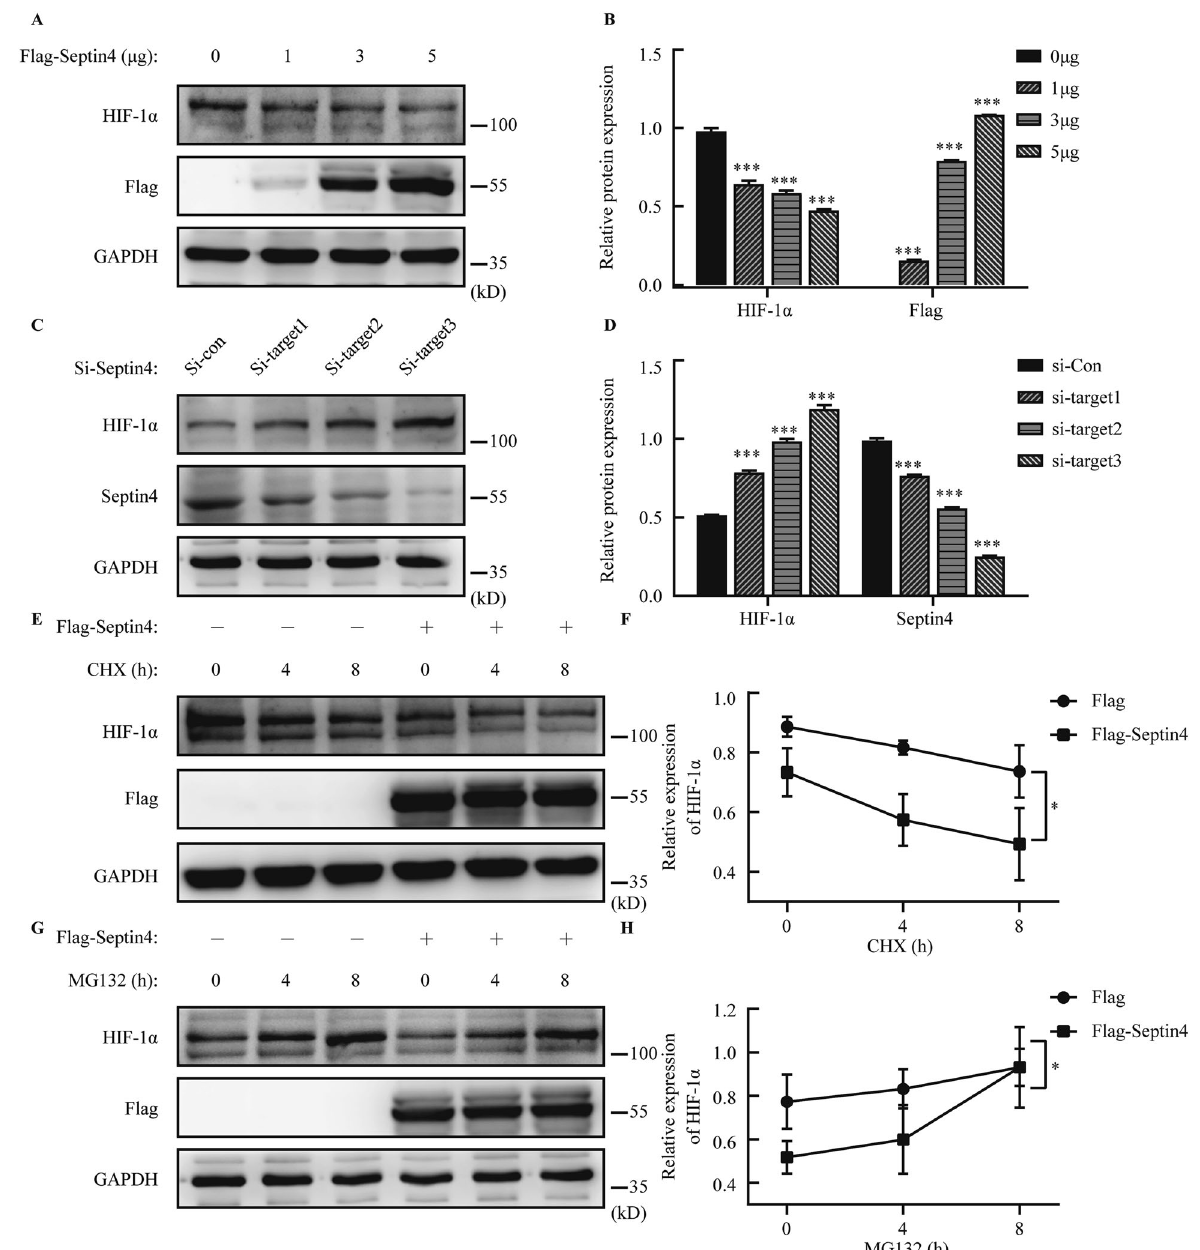
Fig. 4 Septin4 mediates the proteasome degradation of HIF-1 α . A , B Western blot analysis of the gradient overexpression of Septin4 and the changes of HIF-1 α protein expression levels. C , D Western blot analysis of the knockdown of Septin4 with three different sequences and the changes of HIF-1 α protein expression levels E , F Western blot analysis of the expression levels of HIF-1 α under the treatment of CHX for different hours in H9c2 cells transfected with vector empty or Flag-Septin4. G , H Western blot analysis of the expression levels of HIF-1 α under the treatment of MG132 for different hours in H9c2 cells transfected with vector empty or Flag-Septin4. All data are presented as mean ± SD of three repeated experiments; ***<0.001, **<0.01, *<0.05. One-way ANOVA with Tukey ’ s multiple comparisons test ( B , D ). Two-way ANOVA with Tukey ’ s multiple comparisons test ( F , H